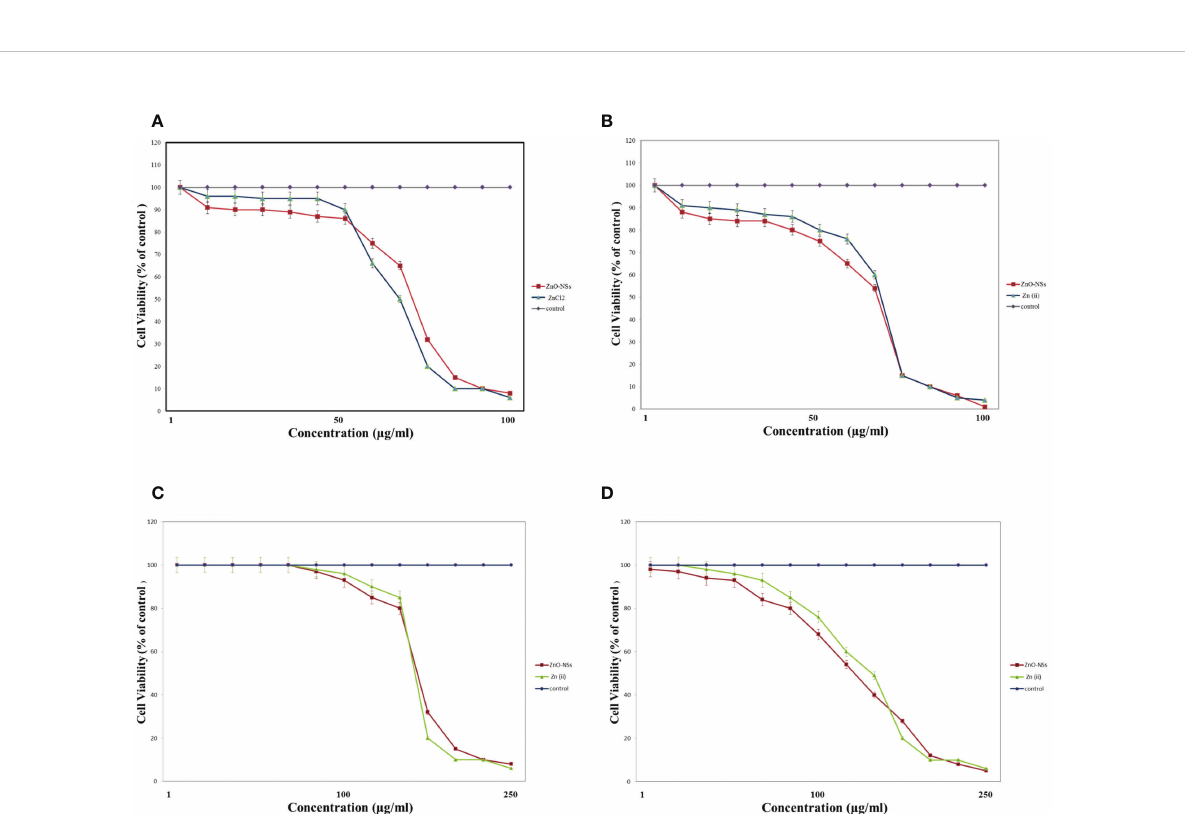
FIGURE 3 Cytotoxicity effect of ZnO nanospheres and released Zn ion different concentrations on HuH7 cell line with concentrations using MTT assay. (A) Cytotoxicity effect of ZnO nanospheres and released Zn ion different concentrations on HuH7 cell lines with concentrations using MTT assay after 24 hour. (B) Cytotoxicity effect of ZnO nanospheres and released Zn ion different concentrations on HuH7 cell line with concentrations using MTT assay after 48 hour. (C) Cytotoxicity effect of ZnO nanospheres and released Zn ion different concentrations on Vero cell line with concentrations using MTT assay after 24 hour. (D) Cytotoxicity effect of ZnO nanospheres and released Zn ion different concentrations on Vero cell line with concentrations using MTT assay after 48